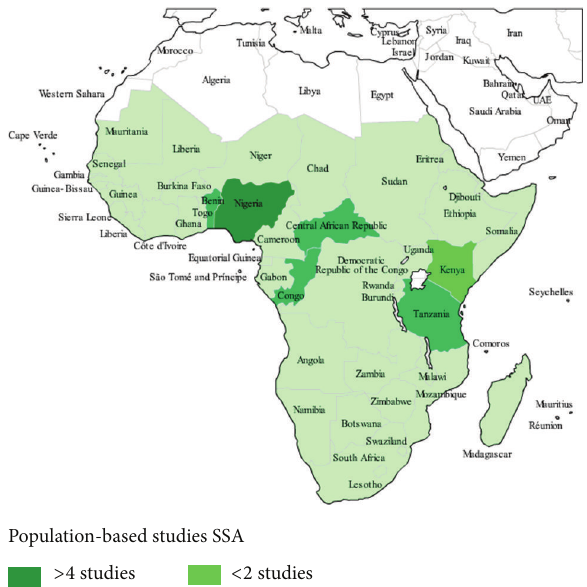
Figure 2: Distribution of population-based studies on the epidemi- ology of dementia in